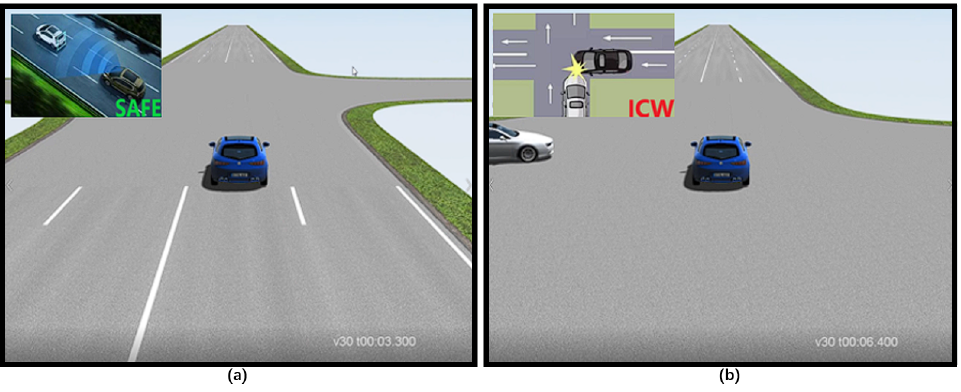
Figure 15. FCW test: ( a ) safe at 3.3 s, ( b ) warning at 6.4 s.